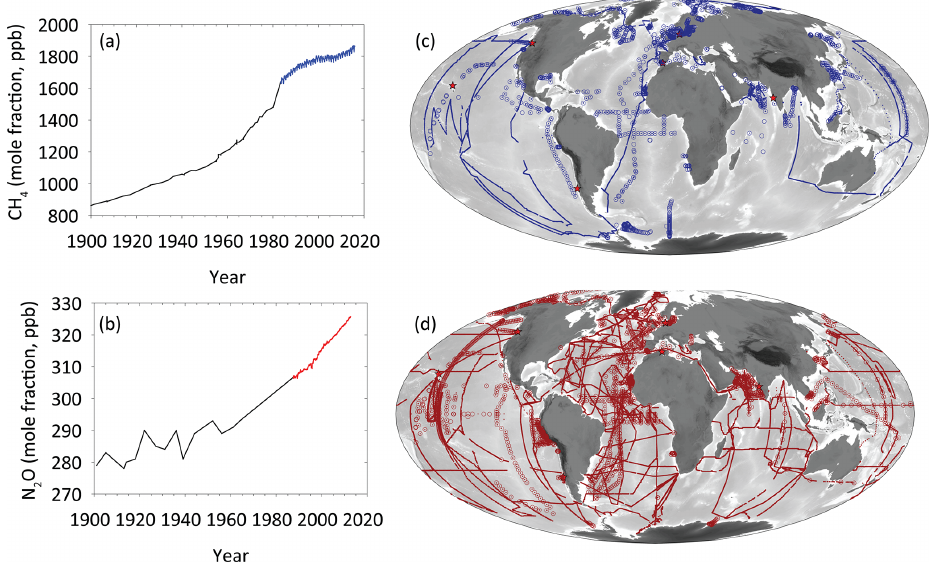
Figure 1. Atmospheric values of (a) CH 4 and (b) N 2 O with the black lines reconstructed from ice-core measurements (Etheridge et al., 1998; Machida et al., 1995) and the colored lines from Mauna Loa Observatory (https://www.esrl.noaa.gov/gmd/dv/data/, last access: 1 July 2020). Global maps of marine (c) CH 4 and (d) N 2 O measurements available from the MEMENTO database (https://memento.geomar.de/, last access: 1 July 2020). The 2018 workshop focused on the marine contribution to atmospheric CH 4 and N 2 O and the underlying microbial and biogeochemical control